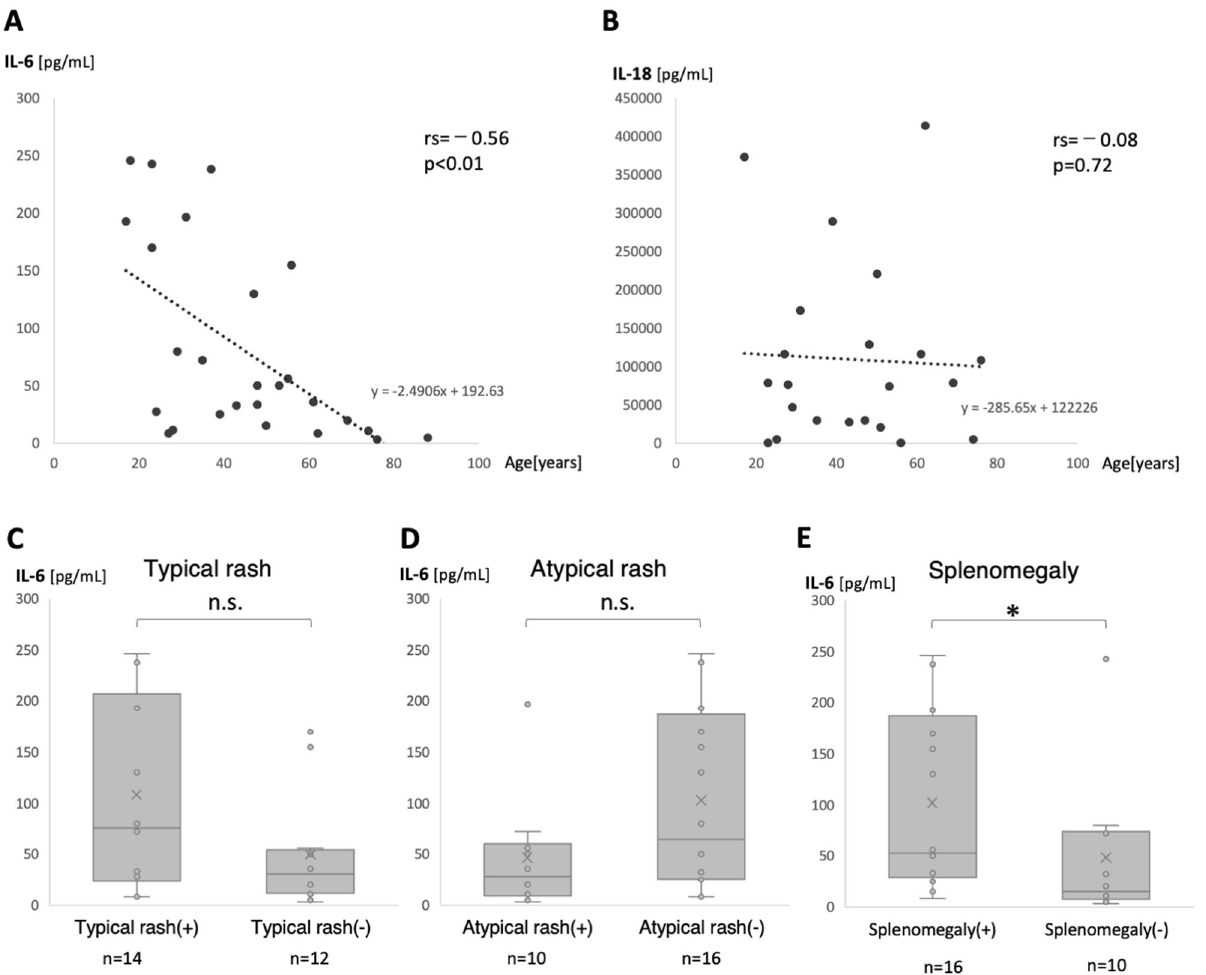
Figure 2. Correlation between cytokines and age at onset and between IL-6 and clinical manifestations. ( A ) Serum IL-6 showed a significant negative correlation with age (n = 26). ( B ) Serum IL-18 showed no significant correlation with age (n = 22). ( C ) Serum IL-6 levels tended to be higher in patients with typical skin rash than in those without, although the difference was not significant ( p = 0.12). ( D ) Serum IL-6 levels tended to be lower in patients with atypical skin rash than in those without, although the difference was not significant ( p = 0.14). ( E ) Serum IL-6 levels were significantly higher in patients with splenomegaly than in those without ( p = 0.04). ( A ), ( B) : p -values were assessed by use of the Spearman rank correlation coefficient between age and serum cytokine concentration. ( C )–( E ): p -values were assessed by use of the Mann–Whitney U test to compare the 2 groups. n.s. not significant; * p <